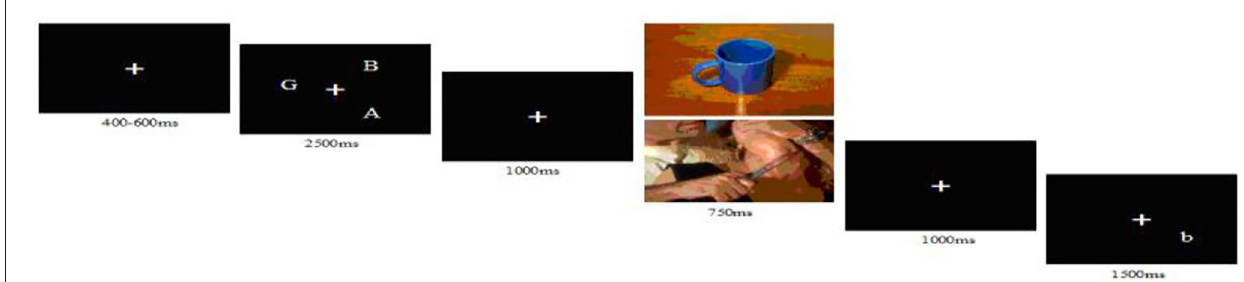
FIGURE 1 | The sequence of events in a trial. The picture was neutral or negative.